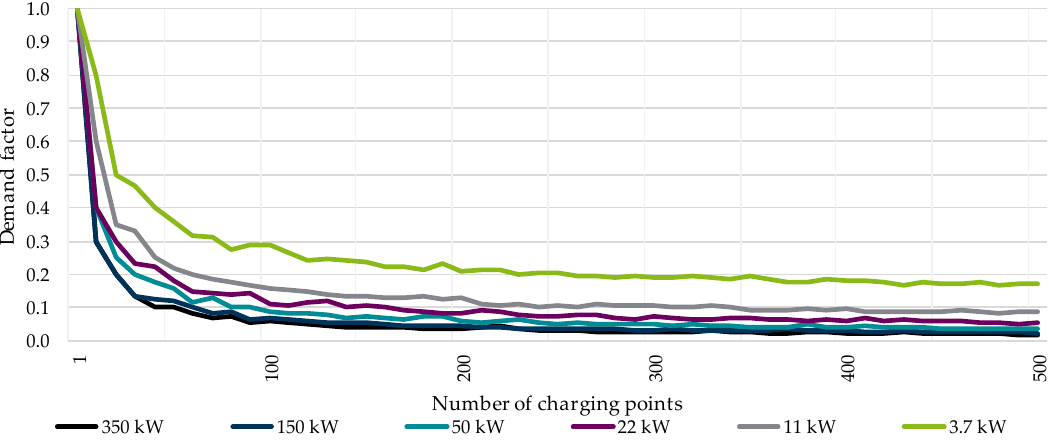
Figure 7. Example of calculated demand factors for six charging powers.